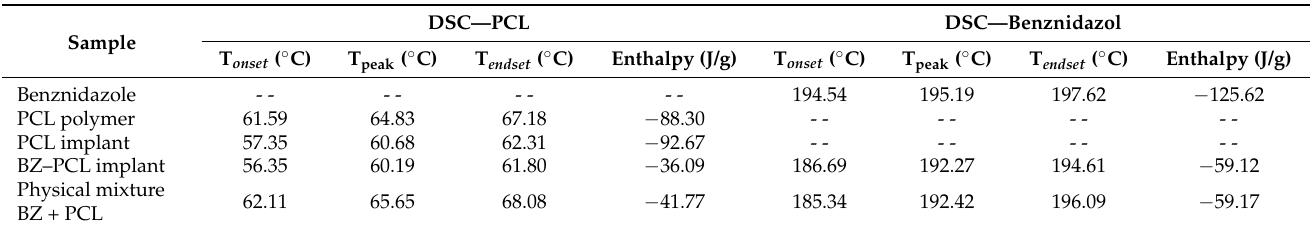
Table 2. Comparative onsets, endsets, peak temperatures, and enthalpy of endothermic events determined from DSC curves (Figure